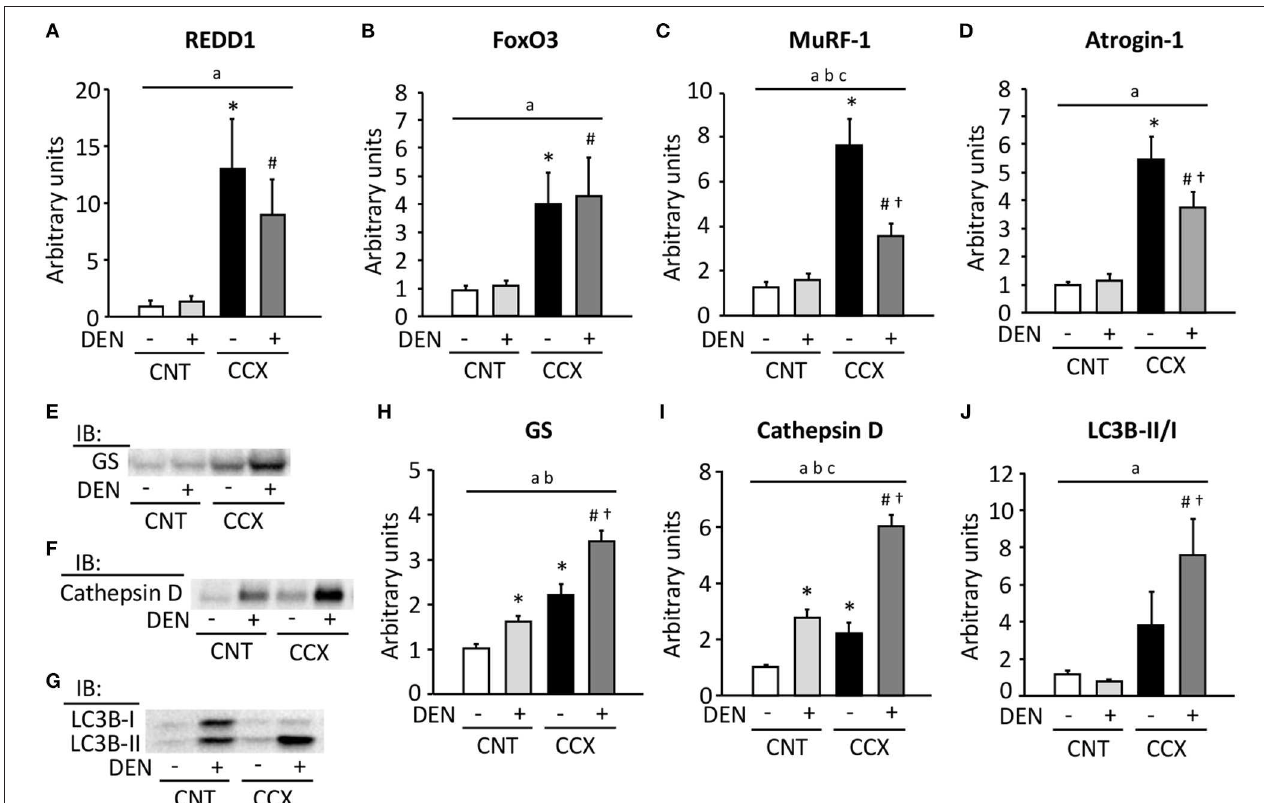
FIGURE 3 | Cancer cachexia increases the expression levels of ubiquitin ligases mRNA and autophagy-related proteins in denervated mouse gastrocnemius muscles. The expression levels of regulated in development and DNA damage responses (REDD) 1 (A) , forkhead box O (FoxO) 3 (B) , muscle ring finger protein 1 (MuRF-1) (C) , and atrogin-1 (D) mRNA in gastrocnemius muscles from control (CNT) and cancer cachexia (CCX) mice, with or without denervation (DEN), were normalized to the TATA-binding protein mRNA and expressed as fold change of the mean CNT value, which was set to 1. Representative western blots for glutamine synthetase (GS) (E) , cathepsin D (F) , and microtube-associated protein 1 light chain 3B (LC3B)-I and -II (G) . The expression levels of GS (H) and cathepsin D (I) were normalized to the total protein content seen in the stain free images. The LC3B-II/LC3B-I ratio (J) . Data show mean ± SEM for 5–7 muscles per group. Statistical significance was set at P < 0.05: main effect of a CCX and b DEN; c interaction of CCX and DEN; difference vs. *CNT without DEN, # CNT with DEN, and † CCX without